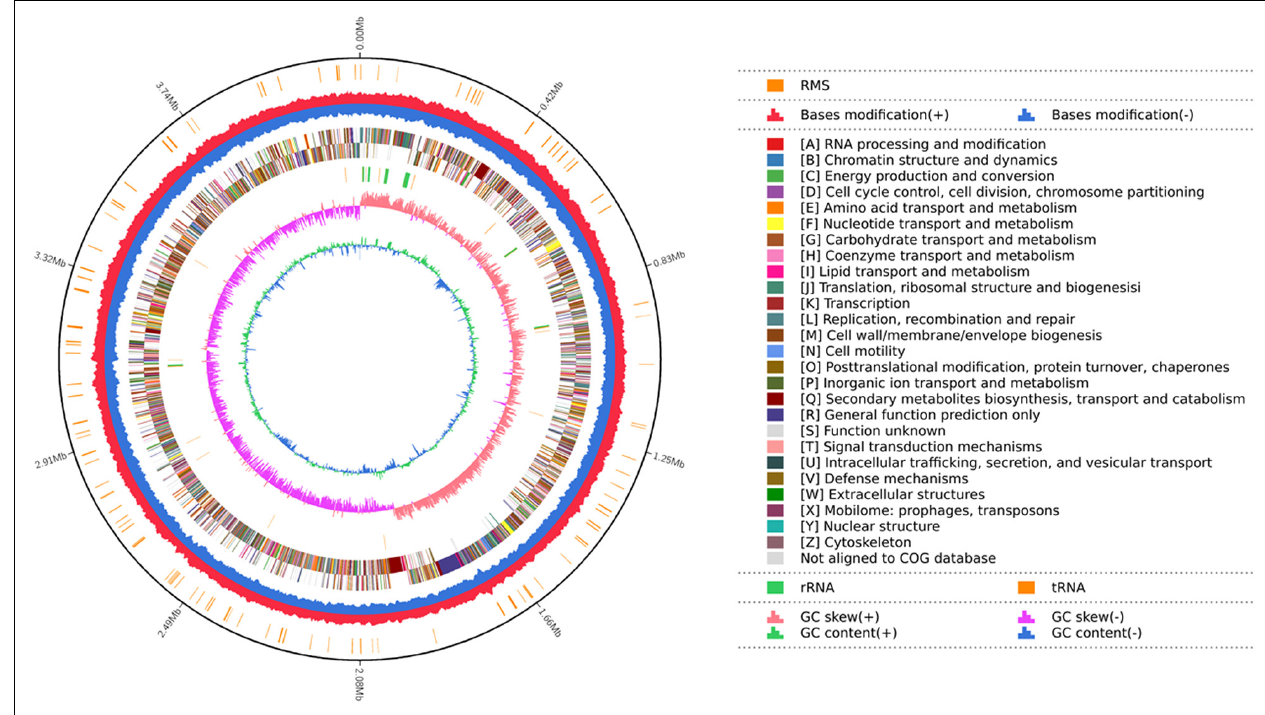
FIGURE 4 | Map of the strain YB-04 genome. The distributions of circles from outwards to inwards are as follows: ring 1 for genome size (black line); ring 2 for the restriction modification system, for forward strand (red) and reverse strand (blue); ring 3 for COG classifications of protein-coding genes on the forward strand and reverse strand; ring 4 for the distribution of tRNAs (brown) and rRNAs (green); ring 5 for GC skew; ring 6 for GC content.